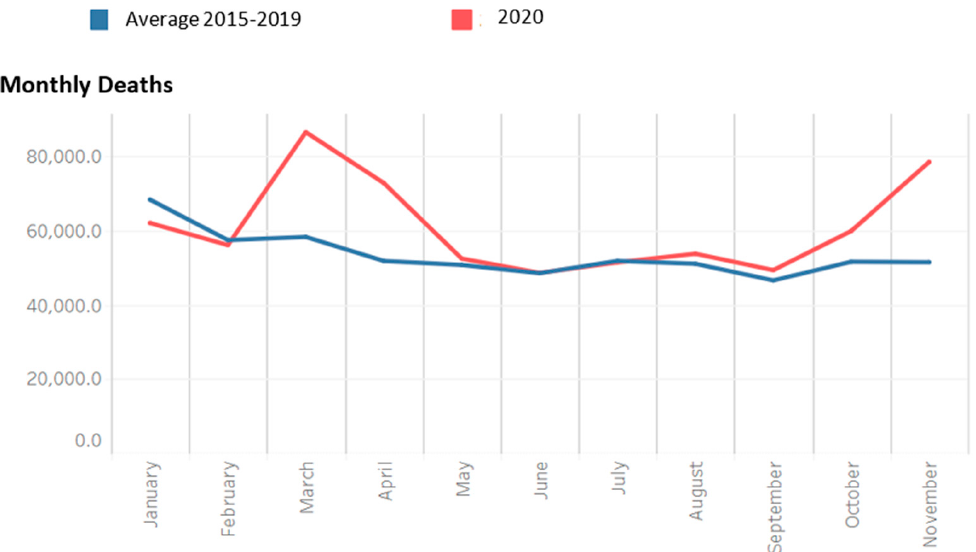
Figure 2. Mortality data for 2020 and average 2015–2019 (ISTAT). This figure was created by elabo- rating raw data from ISTAT [13].